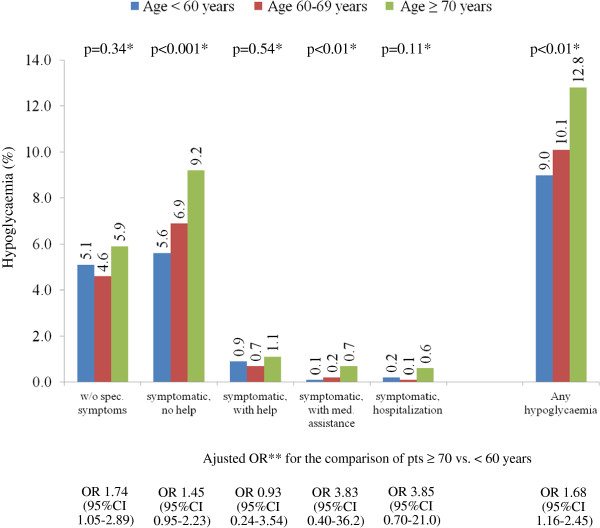
Proportion of patients with at least one episode of anamnestic hypoglycemia per severity (12 months prior to baseline) in the elderly and the young.Legend: Odds ratios were adjusted for differences in baseline characteristics. * Cochran-Armitage or Jonchkheere-Terpstra test; **Adjusted for gender, concomitant diseases (CAD, PAD, heart failure and depression) and blood glucose levels (HbA1c, fasting and postprandial blood glucose).